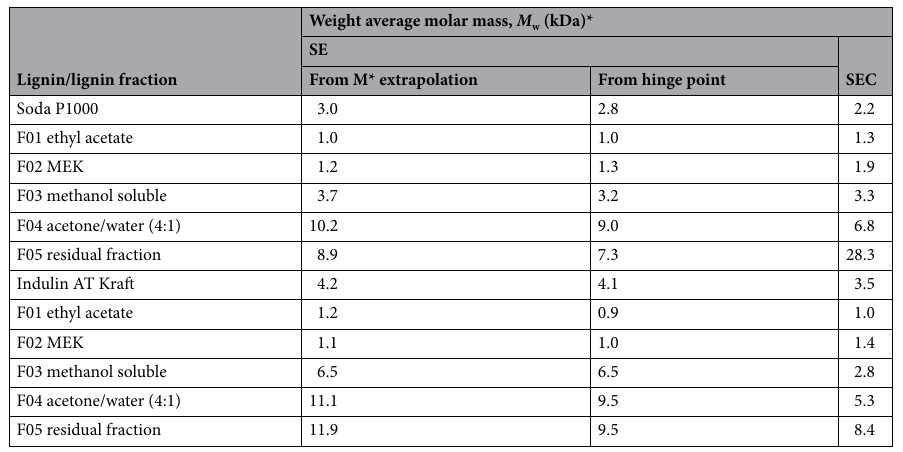
Table 2. Comparison of sedimentation equilibrium (SE) and alkaline size exclusion chromatography (SEC) methods to determine the weight average molar masses ( M w ) of P1000 soda lignin from mixed wheat straw/ sarkanda grass and Indulin AT Kraft softwood lignin. Solvents used to derive fractions F01-F04 are shown. F05 is the residual fraction remaining after the four-step solvent extraction with ethyl acetate, MEK, methanol and acetone:water (4:1). Sedimentation equilibrium (SE) analysis was carried out at 20.0 °C as described in Methods. M w data were derived using the Sedfit-MStar suite of programmes. *Standard error is 3–5%. Size exclusion chromatography was performed as described in Methods. MEK: methyl ethyl ketone.